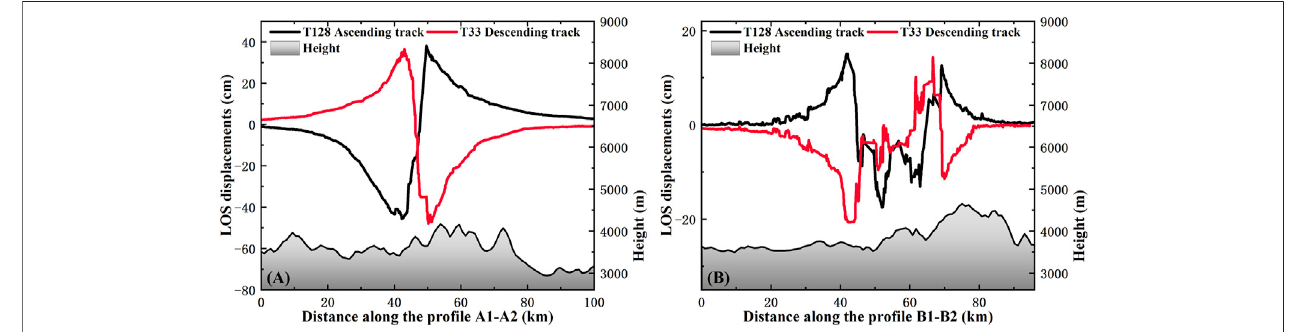
FIGURE 4 | Waveform fi tting of teleseismic data. The red and black curves represent the homogeneous dislocation model and the observed fi ltered P-wave records. The yellowbackground shadings are the 200 random synthetic waveforms. The variance reduction histogram is at the top right, and the time-shift histogram is at the bottom left. The red data traces in each waveform subplot are residual traces between the data and the synthetics. The lowest right subplot shows the spatial distribution of teleseismic stations.